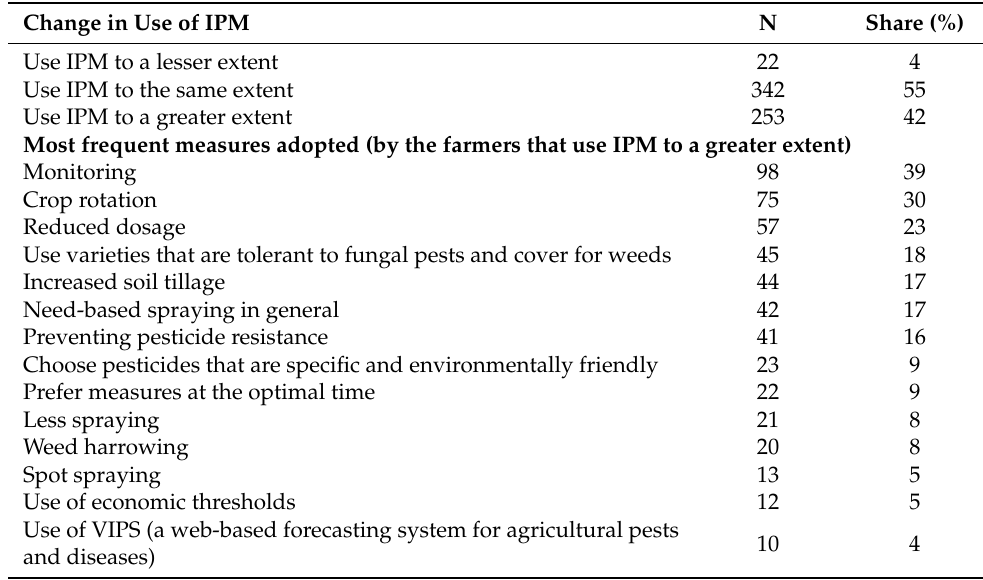
Table 3. Farmers’ self-reported change in the use of IPM during the last 5 years 1 and the most frequent measures adapted (N = 617,